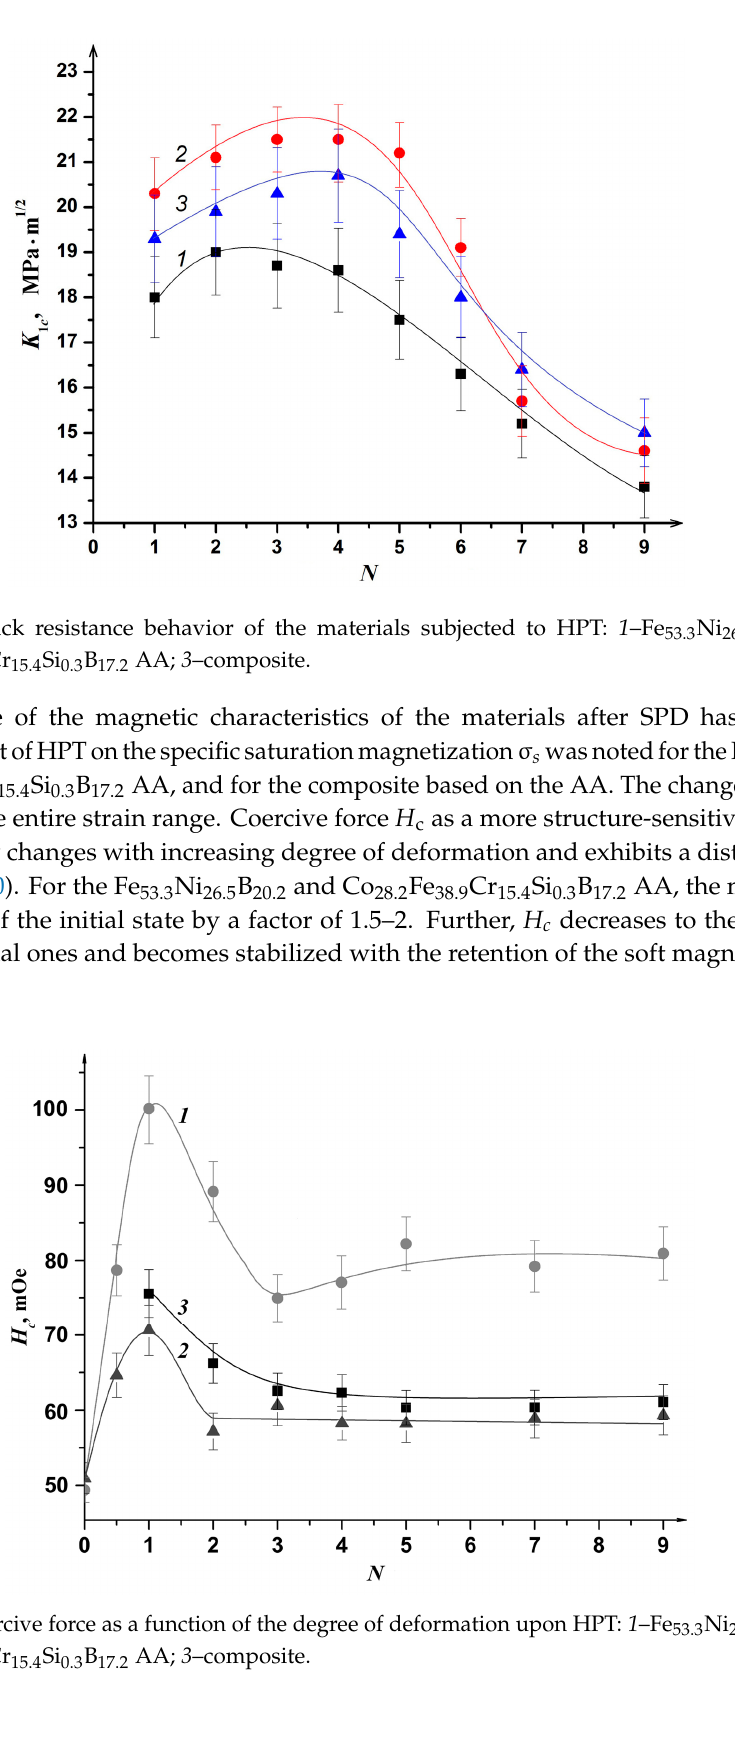
1 c parameter of the Fe 53.3 Ni 26.5 B 20.2 and Co 28.2 Fe 38.9 С r 15.4 Si 0.3 B 17.2 AA increases at